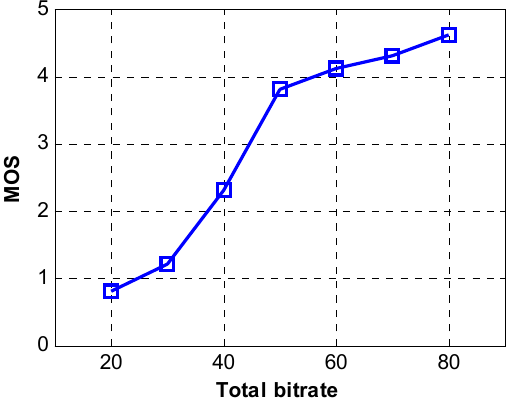
Figure 17. Relationship between quality and bitrate.